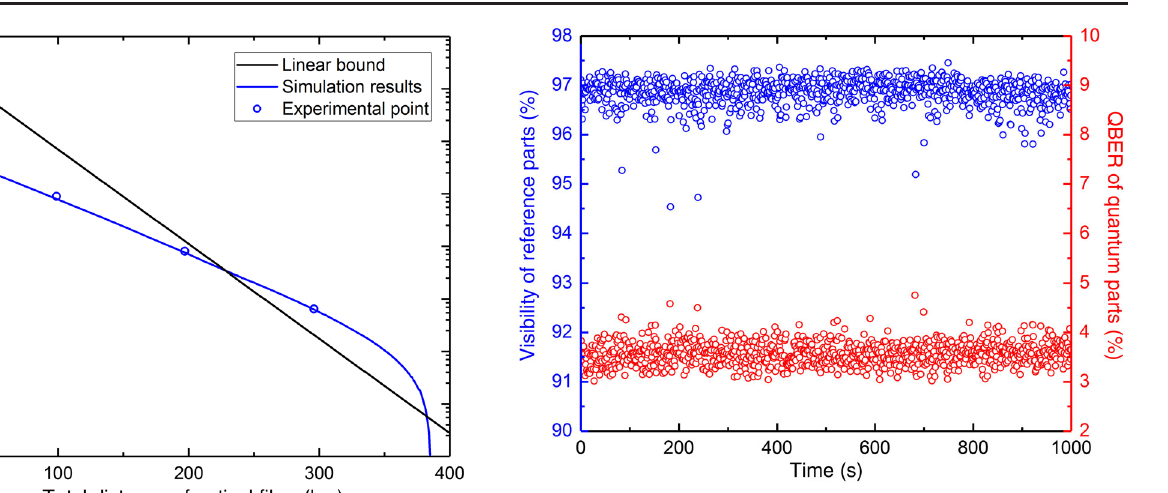
FIG. 4. Key rate of the TF-QKD system. The rates are plotted against the total distance of optical fiber (from Alice to Bob) with a loss efficiency of 0 . 18 dB = km. The open dots refer to experimental points at distances of 100 km, 200 km, and 300 km, respectively.